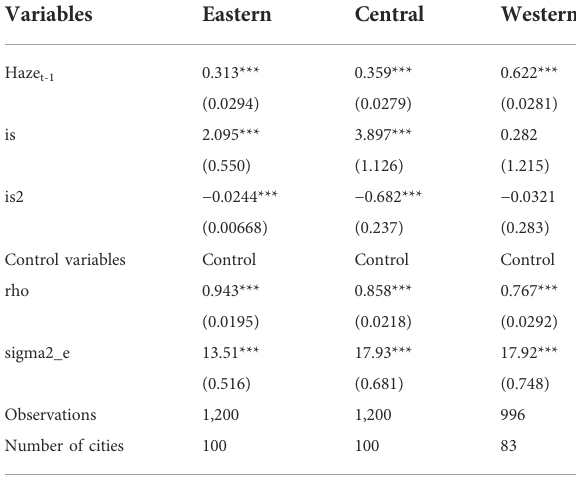
TABLE 3 The in fl uence coef fi cient of industrial structure on haze pollution in different regions.